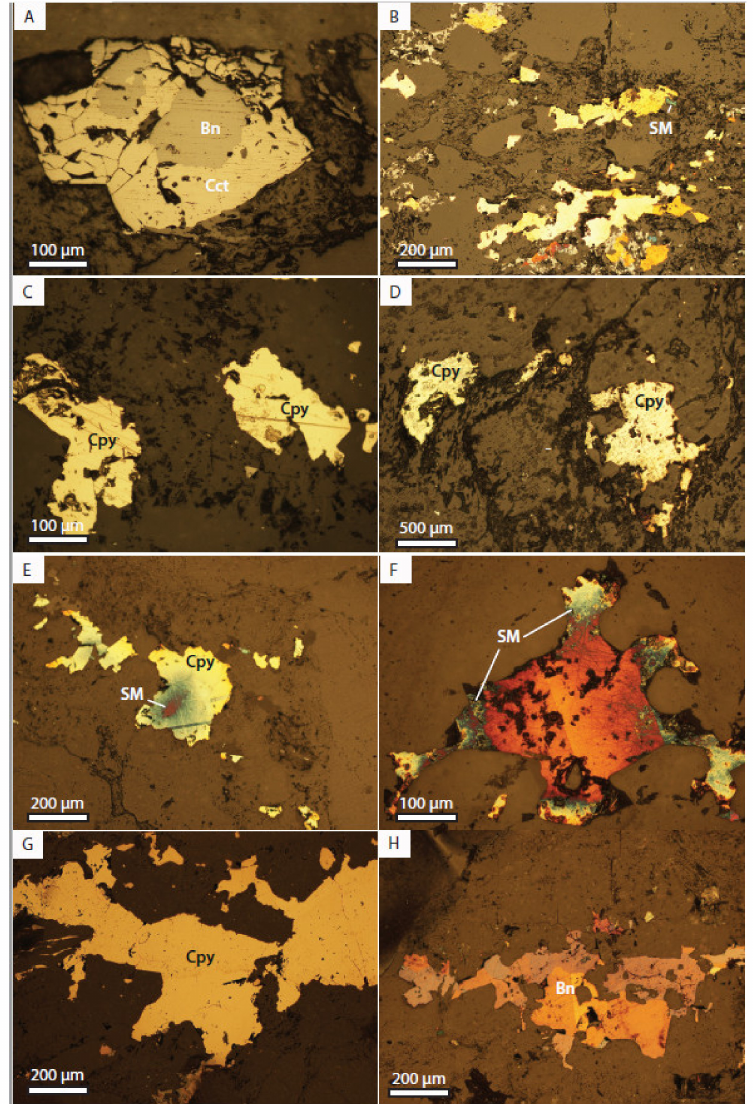
Figure 5. Microphotographs of Ulveryggen samples after 90 days of experiments. The photographs are taken under a reflected light microscope, with crossed polarizers. Setup description is given in Table 1, ( A – H ) microphotographs correspond to #1–8 conditions. ( A ) Intergrowth of chalcocite (Cct) with bornite (Bn, ENV-Ulv-1); ( B ) well-preserved chalcopyrite (Cpy) with minor oxidation of fine grains (ENV-Ulv-2); ( C ) well-preserved chalcopyrite grains (ENV-Ulv-3); ( D ) unaltered chalcopyrite grains (ENV-Ulv-4); ( E ) partly oxidized chalcopyrite grain with secondary mineral and oxidation cover on the surface; ( F ) oxidized Cu sulfide, likely chalcopyrite with secondary minerals formed on the lateral parts; ( G ) well-preserved chalcopyrite grain; and ( H ) micro-assemblage of well-preserved bornite (Bn) with